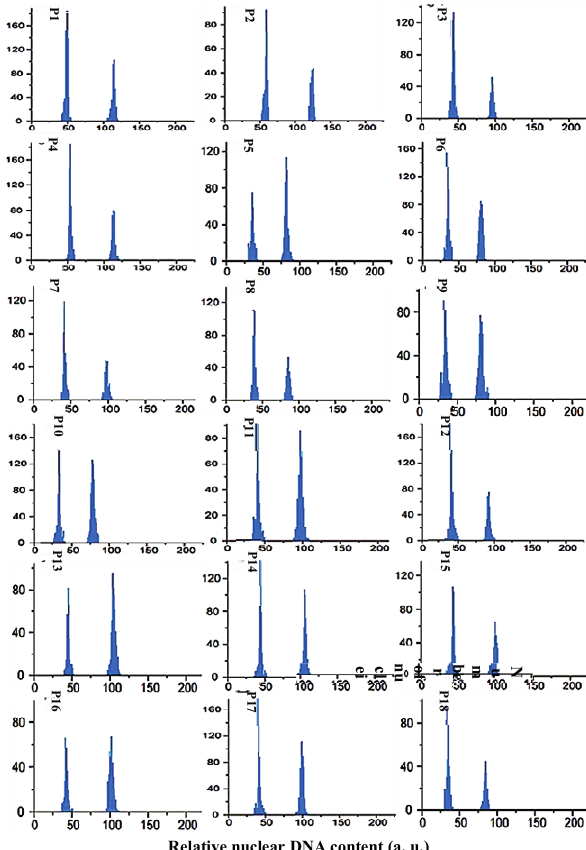
Figure 7. Flow cytometric histograms of monoploid genome size (2Cx DNA (of 18 Iranian endemic Ferula assa-foetida L. popula- tions. Th e left peaks refer to G1 of the Solanum lycopersicum cv. Stupicke (2C DNA = 1.96 pg) reference standard and the right peaks refer to G1 of Ferula assa-foetida L.